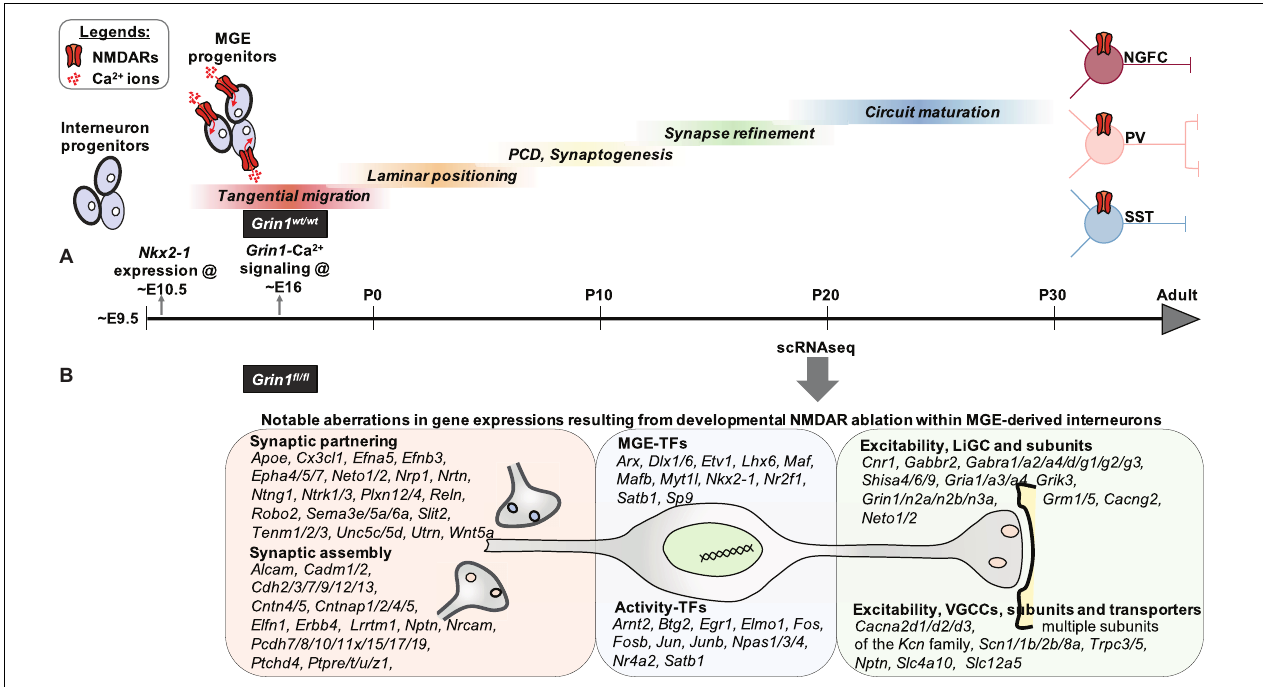
FIGURE 9 | Transcriptional control of MGE-derived interneuron development, synaptic partnering, and excitability are mediated by NMDAR signaling. (A) Nkx2.1 expression appears at ∼ ED10.5, driving subtype fate in MGE-expressed interneuronal progenitors. Subsequently, their sequential developmental milestones toward circuit refinement appears to be under a combination of innate genetic mechanisms and neuronal activity. While the earliest Grin1 expression is reported at ∼ ED14 in developing brain, MGE-specific NMDAR mediated Ca 2 + is recorded at ∼ ED16. However, the broad role played by interneuron-expressed NMDAR signaling during interneuron development and maturation until now is not well delineated. (B) By driving Grin1 -ablation using Nkx2.1 -driven Cre-recombinase expression, we report the earliest developmental loss of NMDAR signaling, across MGE-derived interneuron subtypes. In particular, by performing scRNAseq assay in MGE-derived interneurons from the neocortex and hippocampus of juvenile mouse brain, we report a broad transcriptional aberration subsequent to loss of NMDAR-signaling. Notably, this expression abnormality involves numerous TFs, synaptogenic and regulators of interneuron excitability, that collectively establish MGE subtype identities and drive their maturation. (TF, transcription factors; LiGC, Ligand-gated ion channel; VGCC, Voltage-gated ion